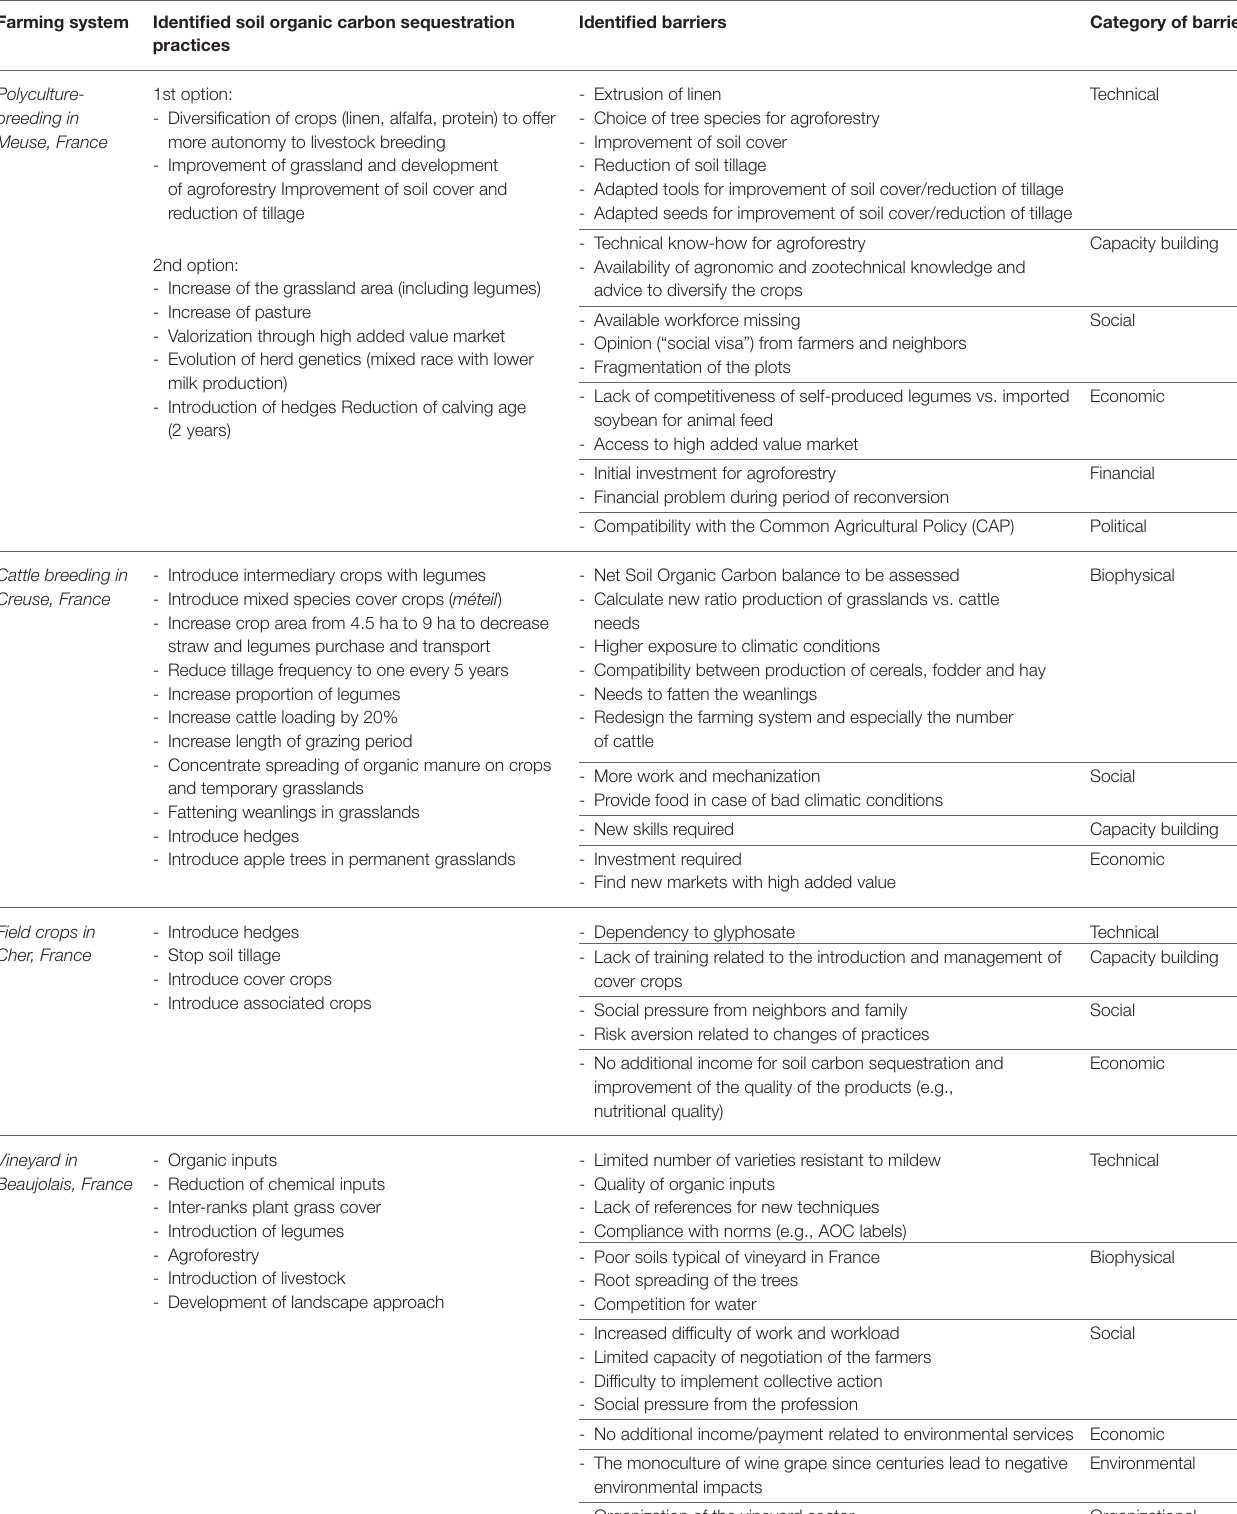
Identified barriers